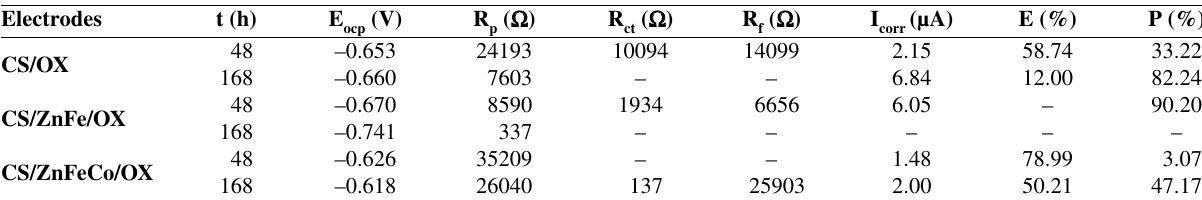
Table 2. Impedance data obtained by simulation of Fig. 7. β